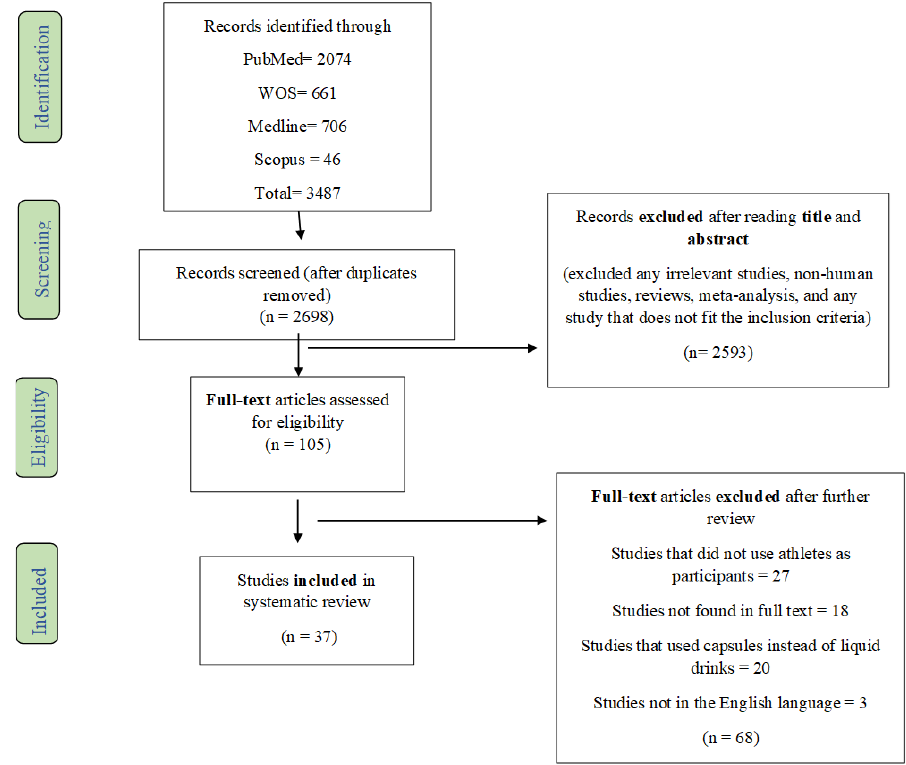
Figure 1. Flow diagram of literature search according to the PRISMA statement.